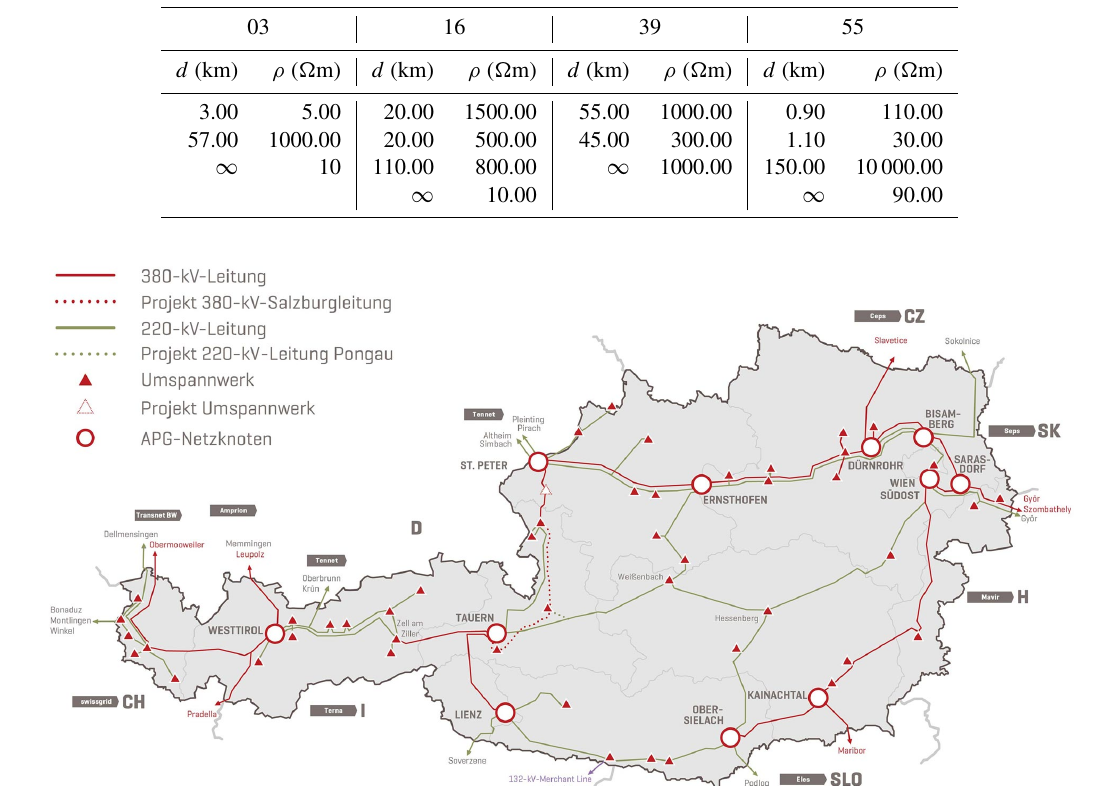
Table 1. EURHOM resistivity models from Ádám et al. (2012) covering most of Austria.